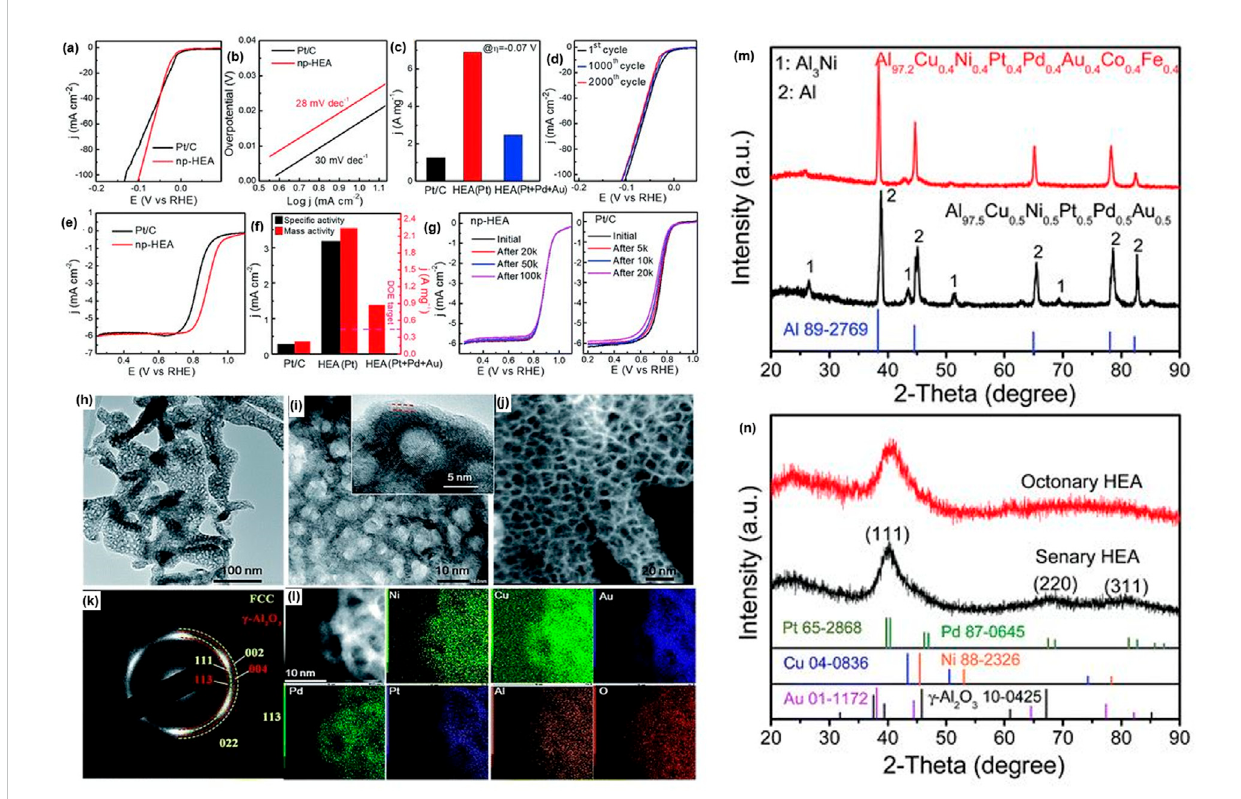
FIGURE 6 (A – G) HER Polarization curves, (H – L) TEM micrographs of the HEA-NP, (M, N) XRD graphs of the octonary and precursor senary alloy before and after dealloying in 0.5 M NaOH